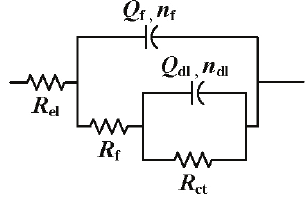
Fig. 4 – Equivalent electrical circuits used for fitting the EIS spectra in Fig. 3